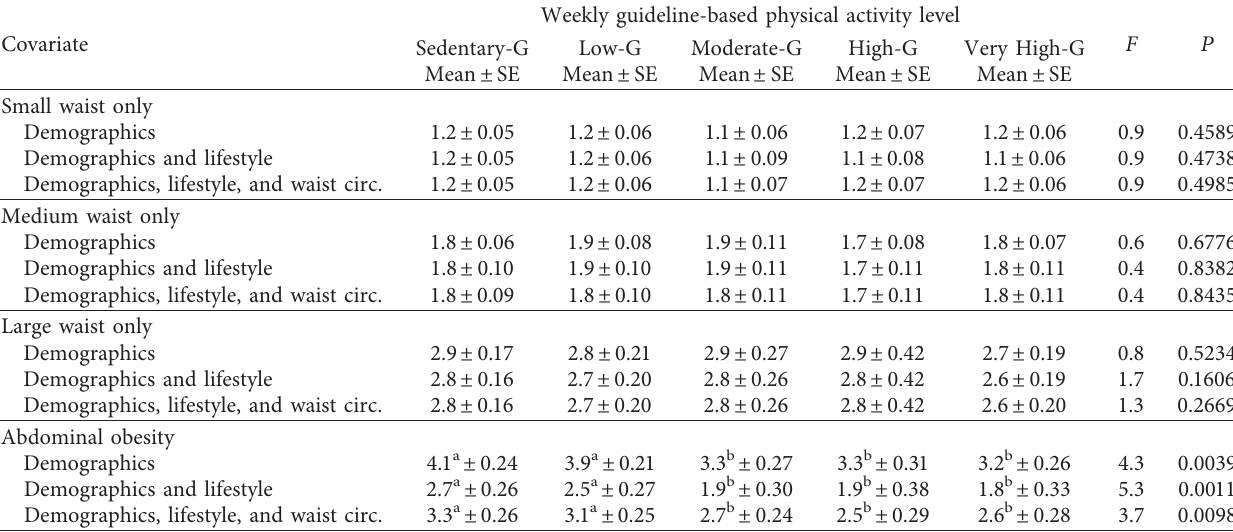
Table 5: Differences in mean HOMA-IR values by level of weekly guideline-based physical activity in US men and women, after adjusting for covariates applied to waist circumference groups divided into sex-specific quartiles. Covariate